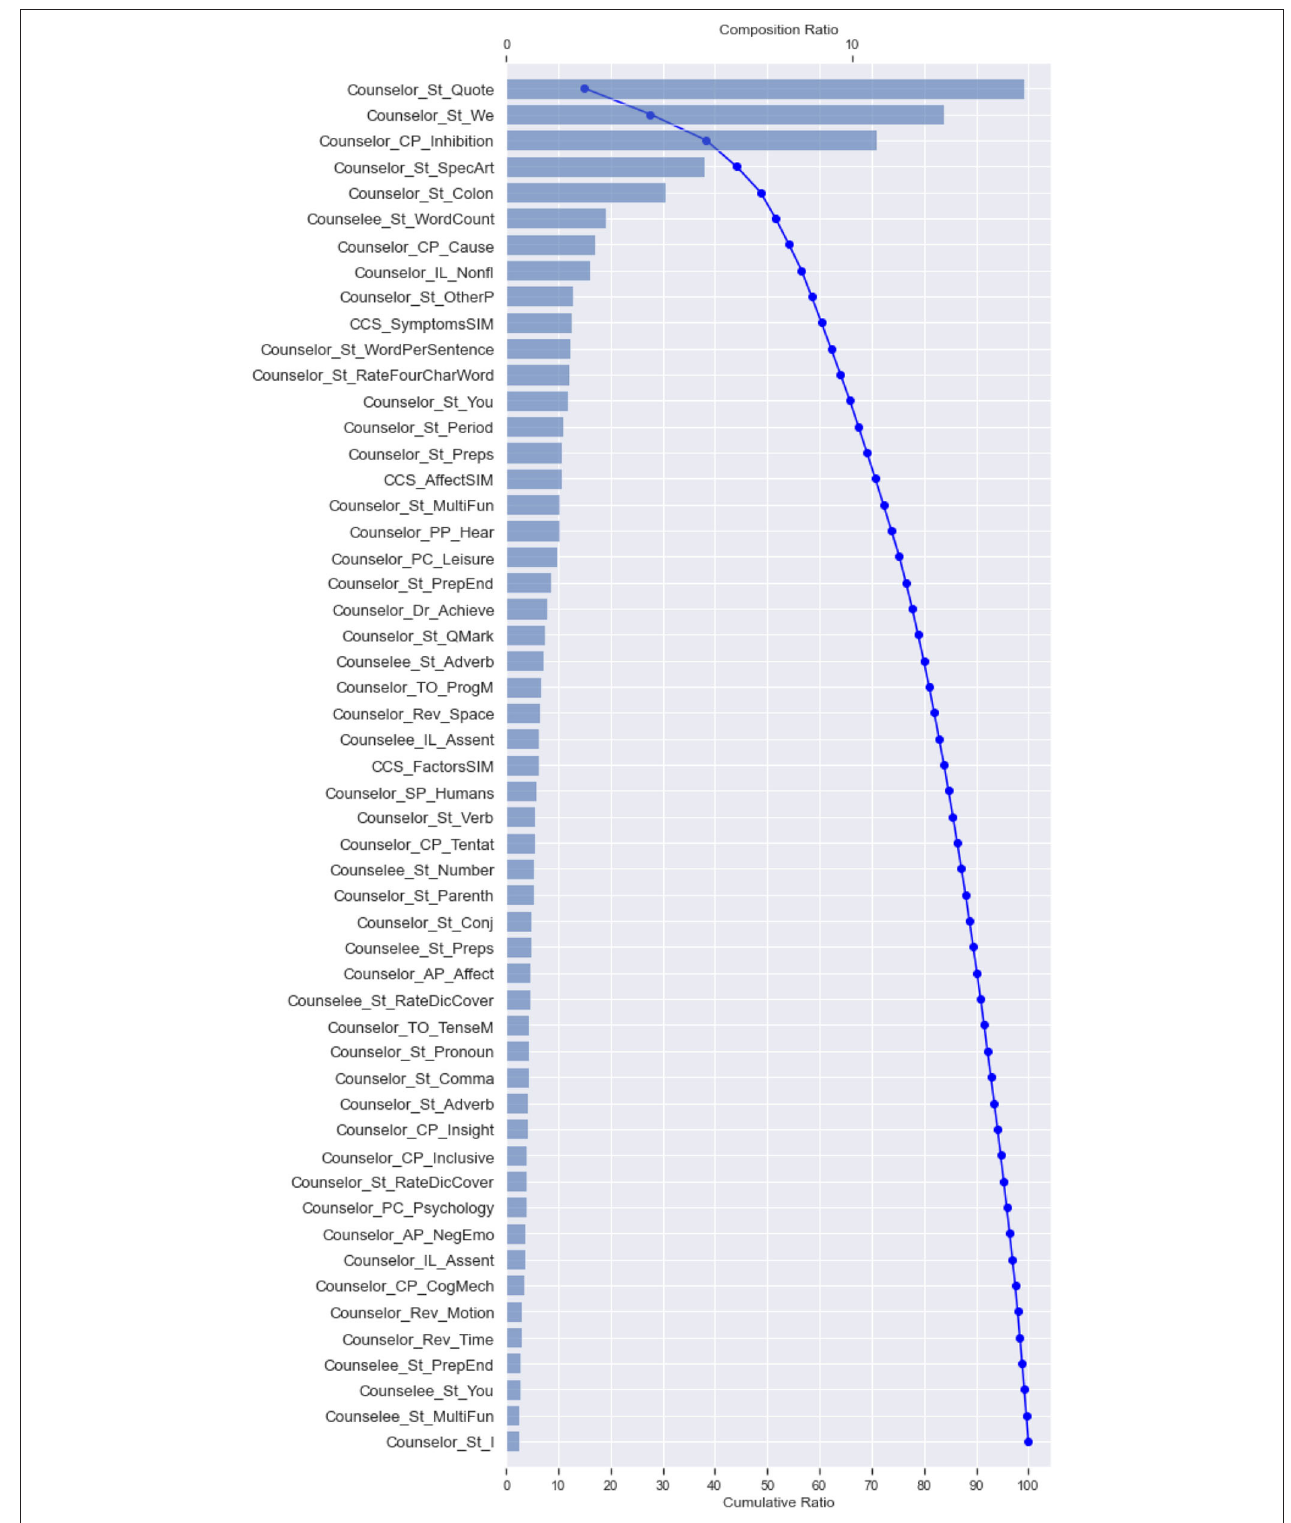
FIGURE 2 | Cumulative SHAP values for top 40 most important linguistic cues in the perceived helpfulness predictive model (In this figure shows the top 40 tokens affecting perceived helpfulness, in order of importance, as determined by the SHAP summary output).